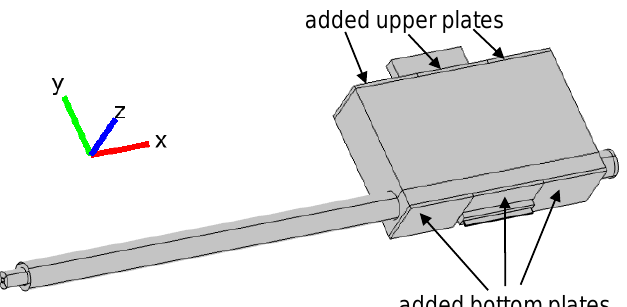
Figure 13. 3D model of the MPSS with added upper and bottom plates (closed configuration).